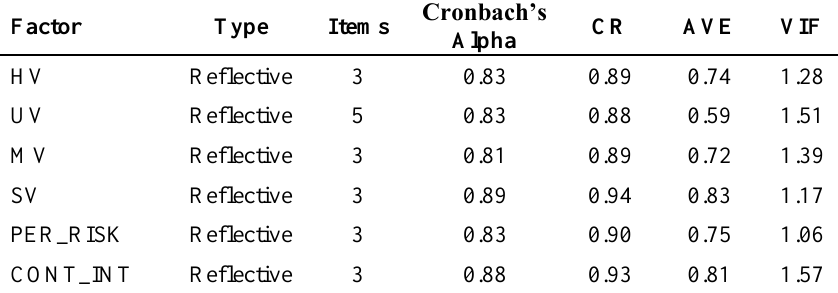
Table 2: Measurement Model Statistics